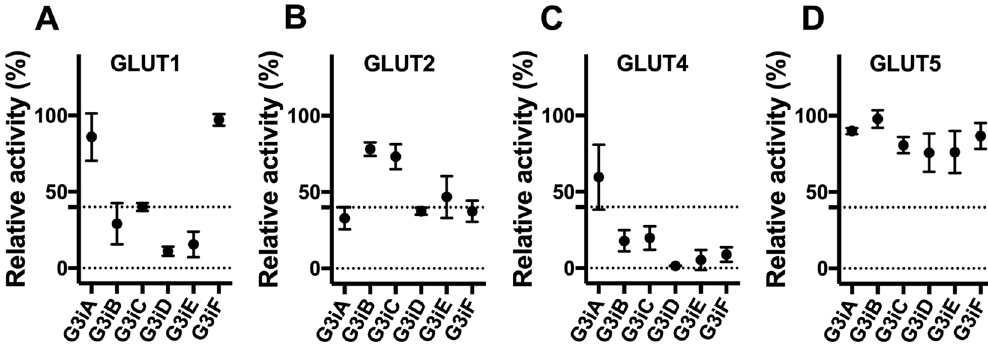
Figure 3. Effect of GLUT3 inhibitors on GLUT1, GLUT2, GLUT4, and GLUT5. The transport activity was assayed as the substrate uptake in hexose transporter-deficient yeast cells expressing functional GLUT1 65 , GLUT2 69 , GLUT4 65 , or GLUT5 66 . Substrate final concentration in the assay matched the corresponding substrate K M and was 5 mM glucose for GLUT1 and GLUT4, 15 mM glucose for GLUT2 ∆loopS_Q455R , and 10 mM fructose for GLUT5 S72Y . Transport assay was initiated by the addition of C 14 -labeled substrate and stopped after 10 min (see “Materials and methods” for details). (A–D) Effect of G3iA-G3iF, at 50 µM concentration, on the relative transport activities of GLUT1 (A) , GLUT2 (B) , GLUT4 (C) , and GLUT5 (D) . Standard deviations for experimental points come from at least three independent measurements.